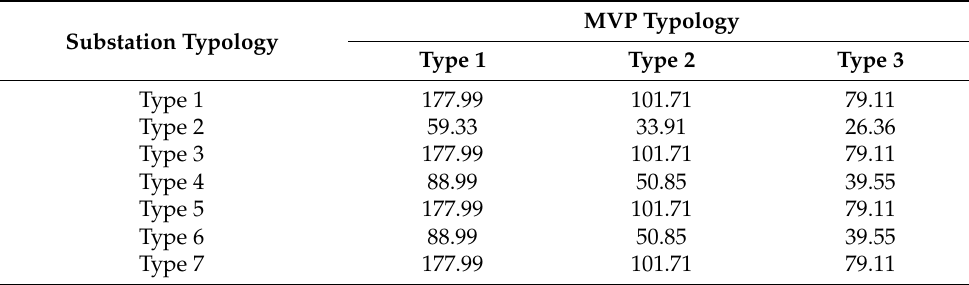
Table 3. RT values (years) of SS outage in case of heat